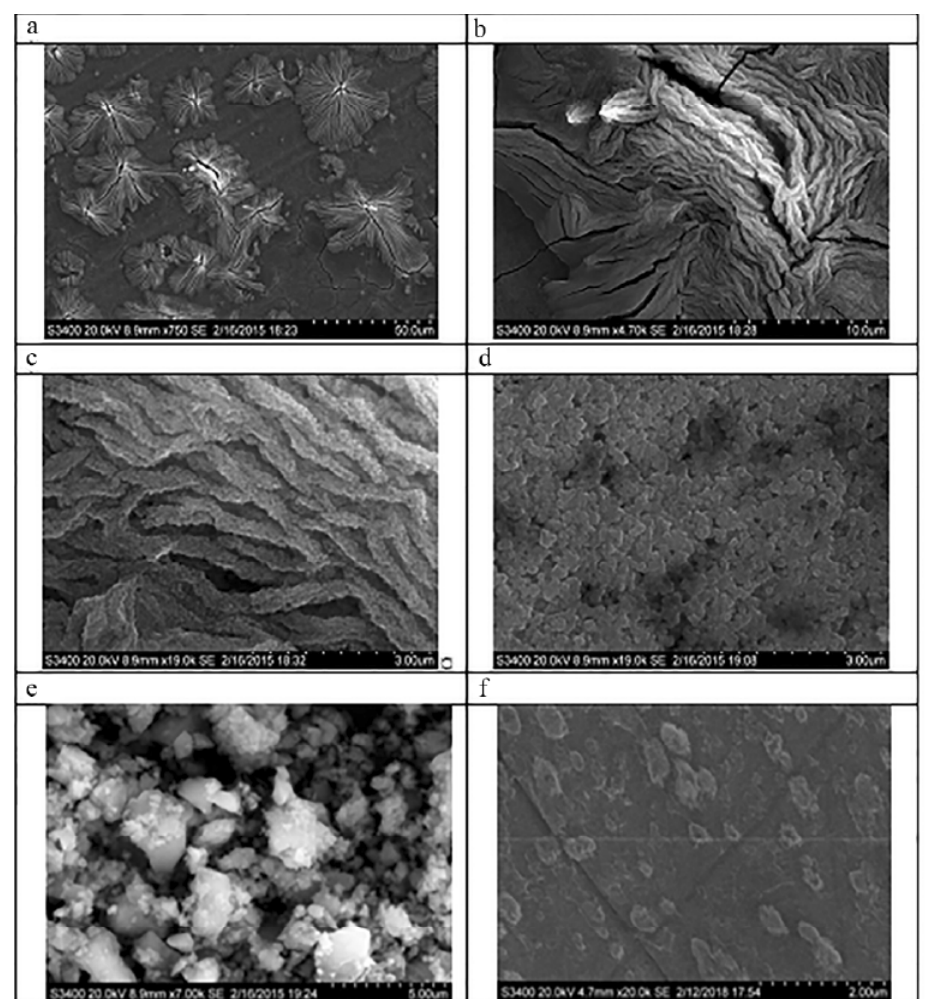
Fig. 7. SEM images of nanoparticles: a, b, c – nickel HCF; d – cobalt HCF, e – copper HCF, f – iron HCF.